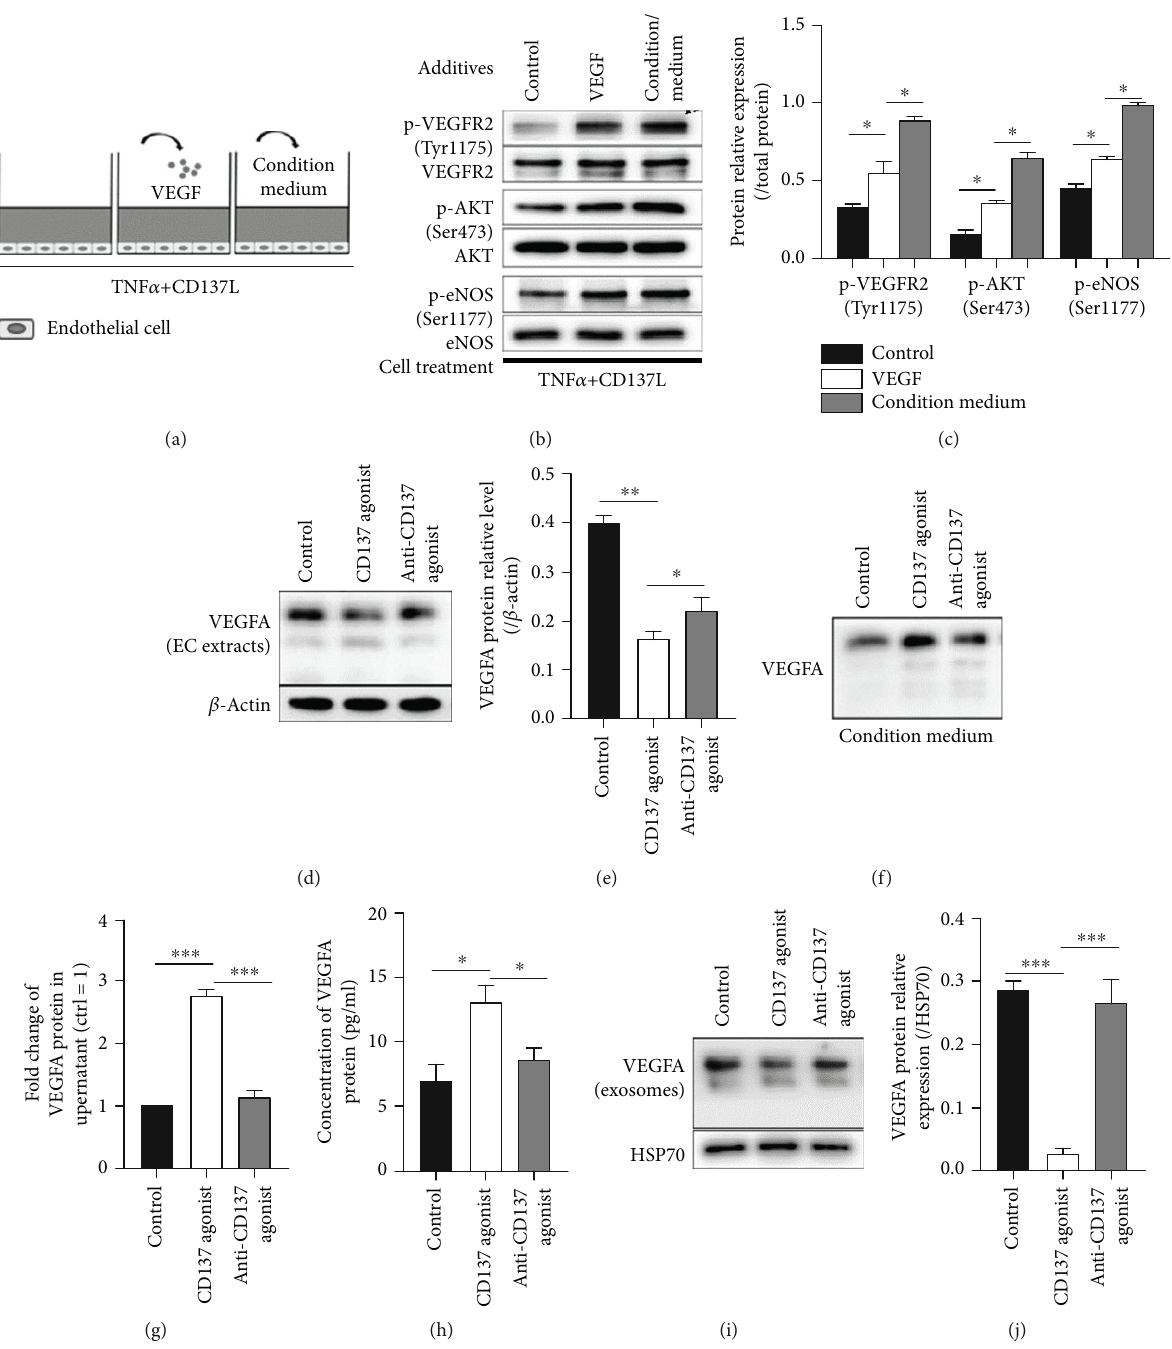
Figure 7: CD137 signaling increased endothelial secretion of VEGFA. (a) Schematic diagram of di ff erent treatments used on CD137- activated ECs. (b) Detection of endothelial p-VEGFR2 (Tyr1173), p-Akt (Ser473), and p-eNOS (Ser1177) proteins by western blot after coculture with VEGFA or condition medium for 3h. (c) The relative expression level of p-VEGFR2 (Tyr1173), p-Akt (Ser473), and p- eNOS proteins. (d, e) Detection of the VEGFA expression from endothelial extracts in control and CD137L groups. The relative VEGFA protein level was quanti fi ed in relation to β -actin. (f, g) The VEGFA expression and relative change of concentrated condition medium in the control and CD137L groups. (h) VEGFA concentration of the condition medium was measured with ELISA detection after treatment with CD137L for 3h. (i, j) The VEGFA expression in exosomes, which derived from the supernatant of the control and CD137L groups. ∗ p < 0 : 05 , ∗∗ p < 0 : 01 , ∗∗∗ p < 0 : 001 , n = 3 . The CD137 agonist group was stimulated with TNF α for 24 hours and then CD137L for 3 hours. The Anti-CD137 group was treated with inhibitory CD137 signaling antibody for 30 minutes then CD137L for 3 hours. Condition medium contained the supernatant after the activation of endothelial CD137 signaling for 3